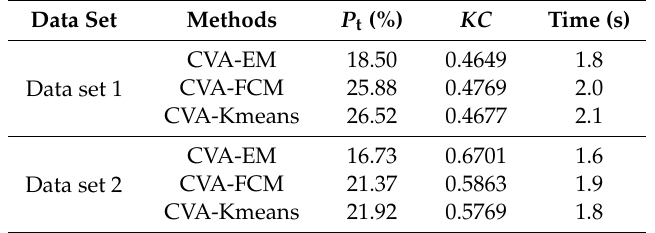
Table 4. The quantitative analysis of experimental results generated by CVA.